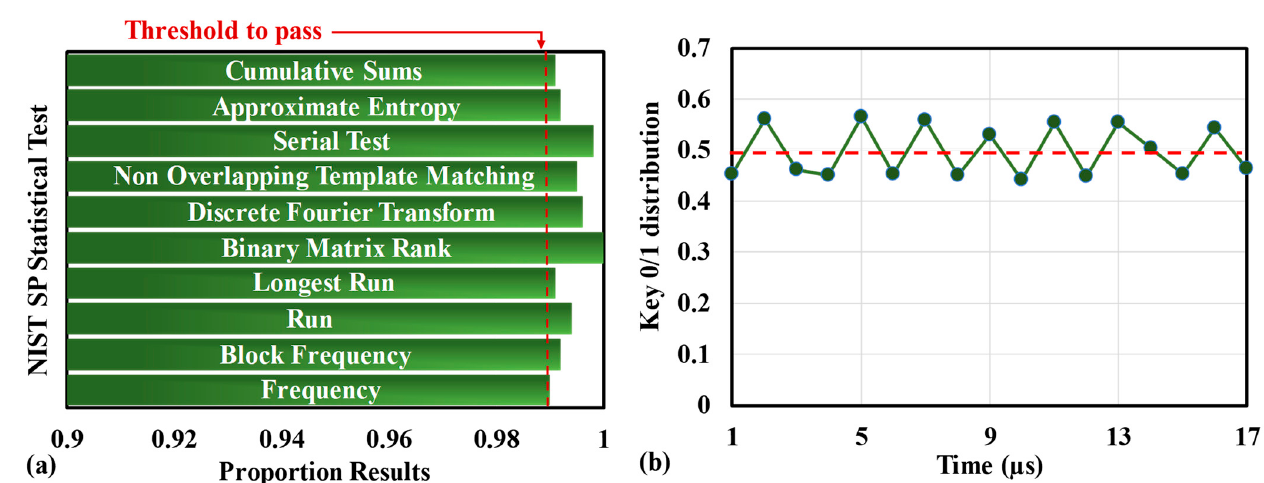
Figure 5. ( a ) Key NIST test results, and ( b ) 0/1 distribution probability of the